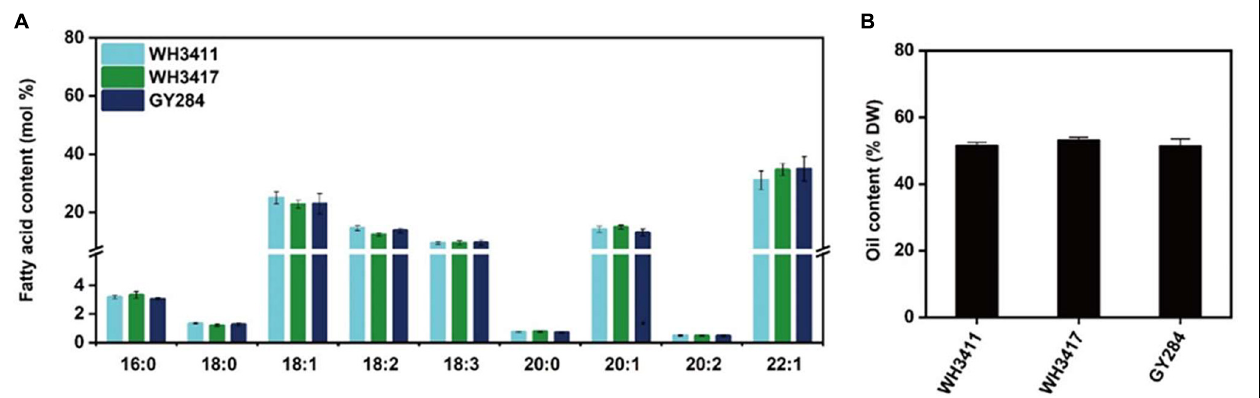
FIGURE 1 | Fatty acid composition and oil content of three germplasms (WH3411, WH3417, GY284). (A) Fatty acids were extracted from mature seeds and analyzed using the gas chromatograph method. Values are means ± SD ( n = 3 ∼ 5). (B) Seed oil content is determined by near infrared spectroscopy. Values are means ± SD ( n = 12 ∼ 20).